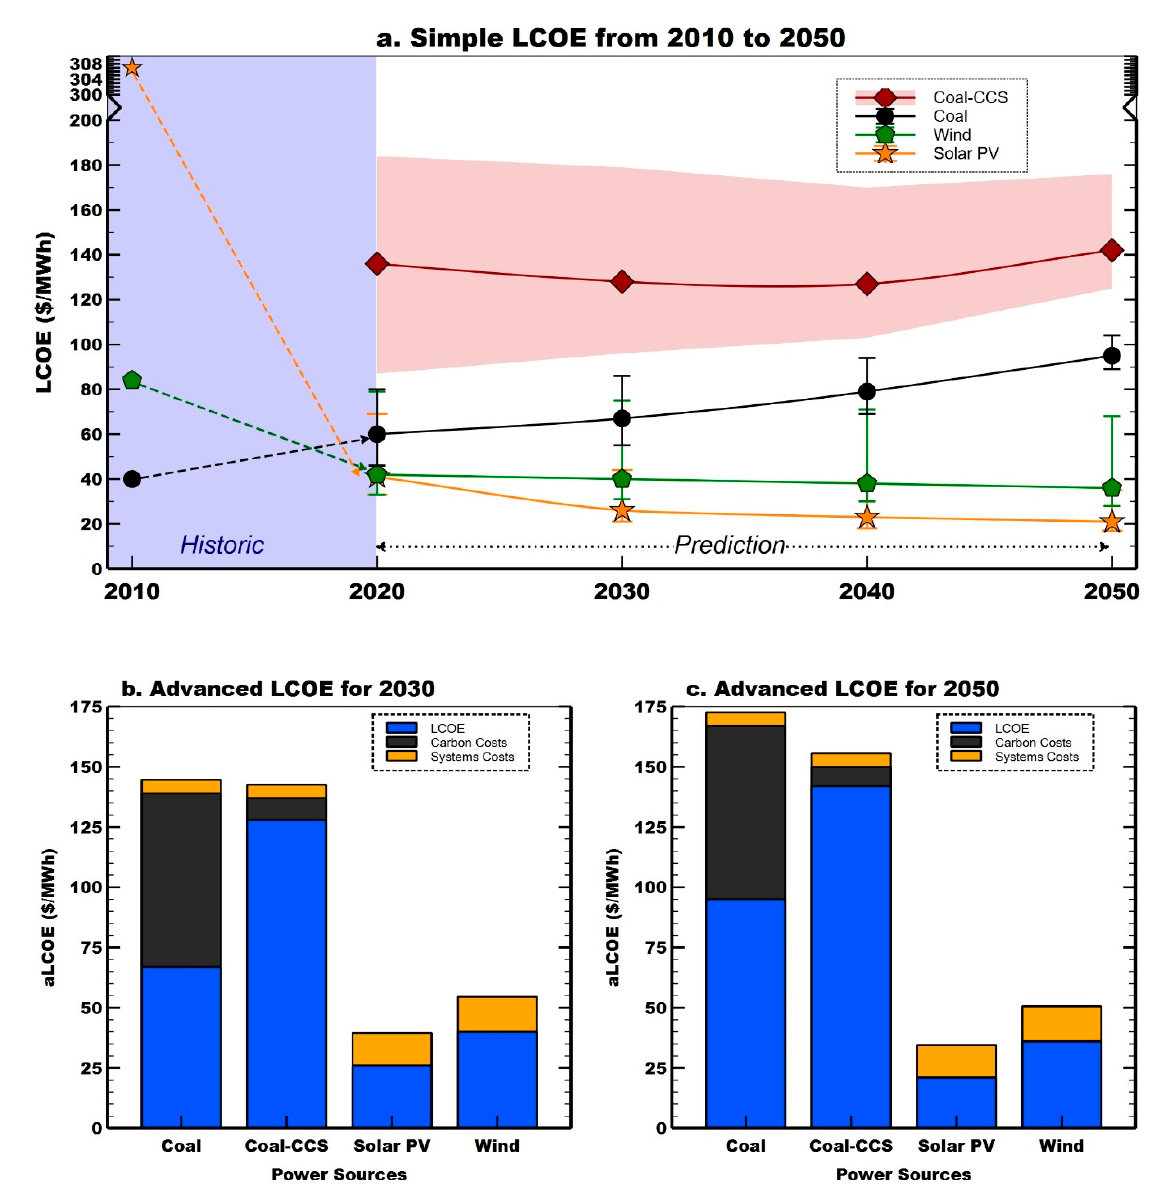
Figure 3. Simple and Advanced LCOE Results: ( a ) Simple LCOE for coal-CCS, coal, solar PV and wind power sources from 2010 to 2050. The area-fill and bars show the low and high LCOE range; ( b , c ) Advanced LCOE estimations for the four power sources in 2030 and 2050 with breakdowns for LCOE, carbon costs and systems costs.